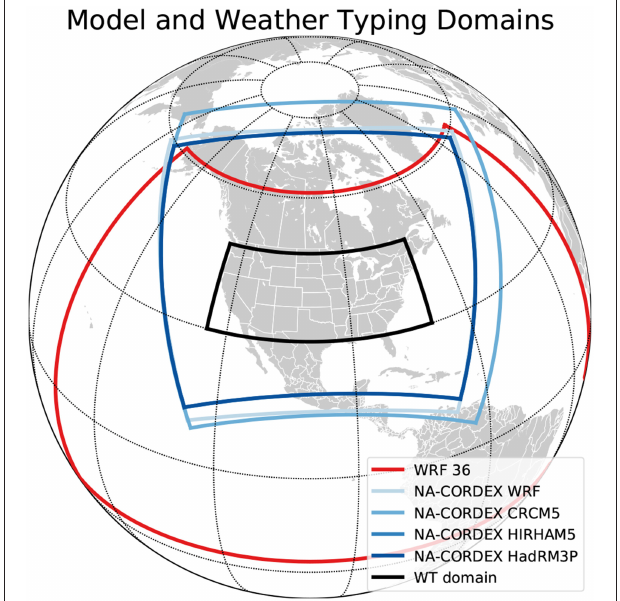
FIGURE 1 | Model (colors) and weather typing domains (black rectangle). The WRF36 domain is shown in red and the NA-CORDEX domains are shown in